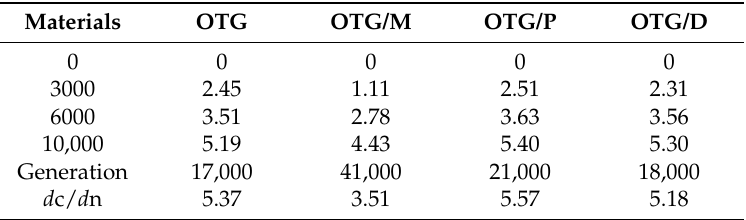
Table 3. Fatigue properties (fatigue crack growth and fatigue crack generation) of elastomer